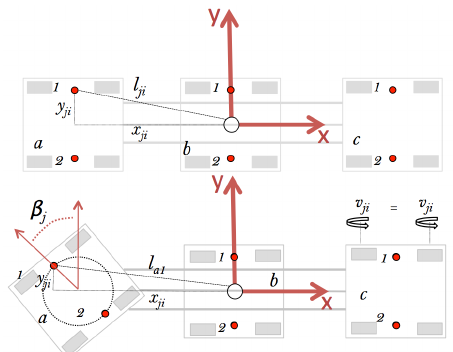
Figure 5. Diagram of the Mantis ’s actuators; the red circle shows the middle point between the actuators of each side i ( i = 1,2) and the position from the inertial system of the robot positioned in the central